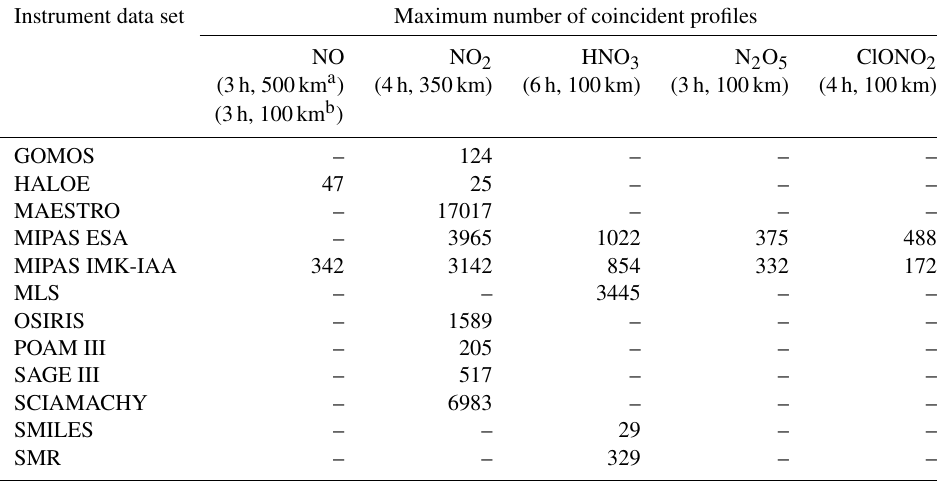
Table 3. Optimized coincidence criteria and maximum number of coincident profiles. Instrument data